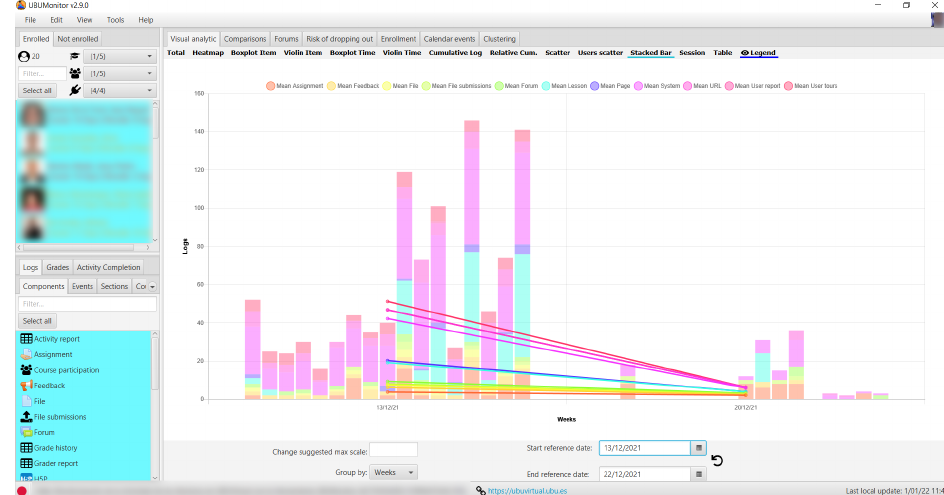
Figure 4. UBUMonitor main window. Participant selection list in the upper left panel; selection list of logs in the lower left panel; the chart with the data of the selection in the central panel.